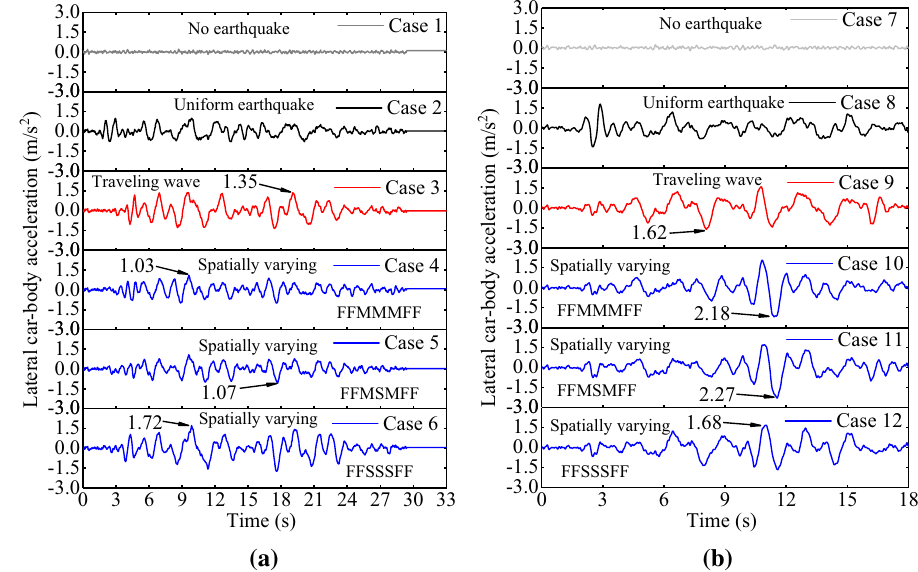
Fig. 12 Time history of the lateral acceleration of the first car body: a cases 1–6; b cases